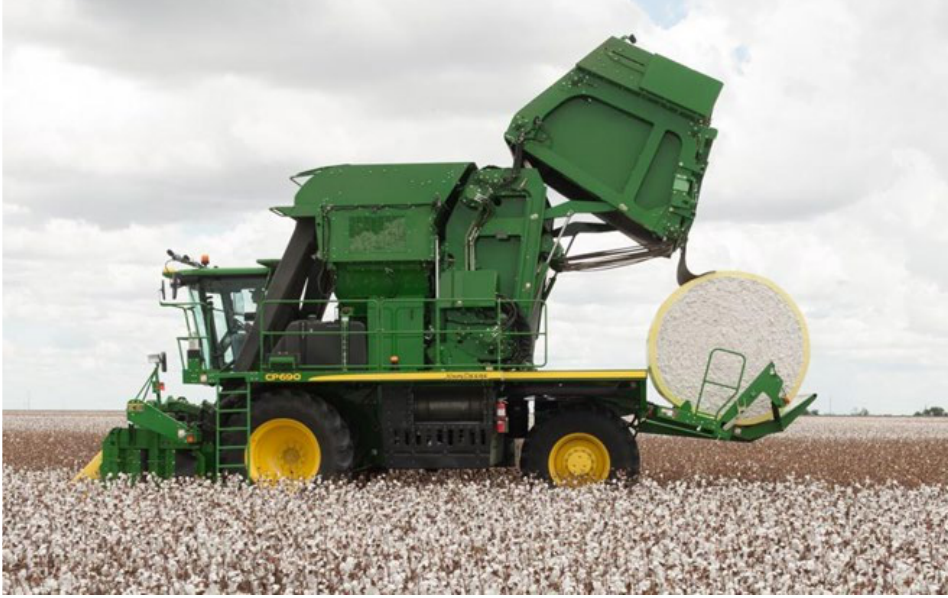
Figure A2. A module building spindle cotton harvester (often referred to as a “picker”). Within the U.S., there are two types of cotton harvesters—a spindle picker and a cotton stripper. The picker uses a series of spindles to selectively remove the seed cotton from the boll. A cotton stripper is much more aggressive and removes a large portion of other plant material (sticks and seed carpel) along with the seed cotton that is later separated at the gin. A challenge for both harvesting systems are extraneous matter that can end up in a cotton field, such as plastic shopping bags and agricultural plastic mulches, and complaints from textile mills about such contamination, which has been on the increase as these mills have added detection systems to find such contaminates.